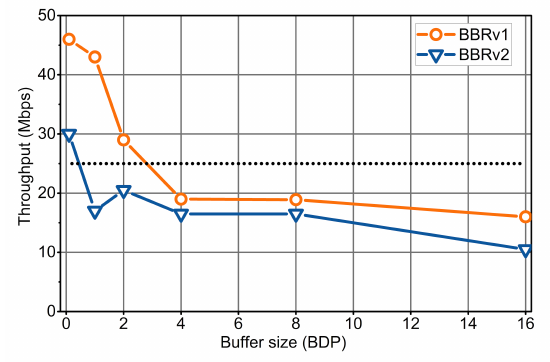
Figure 2. Coexistence with usable throughput for CUBIC [32].